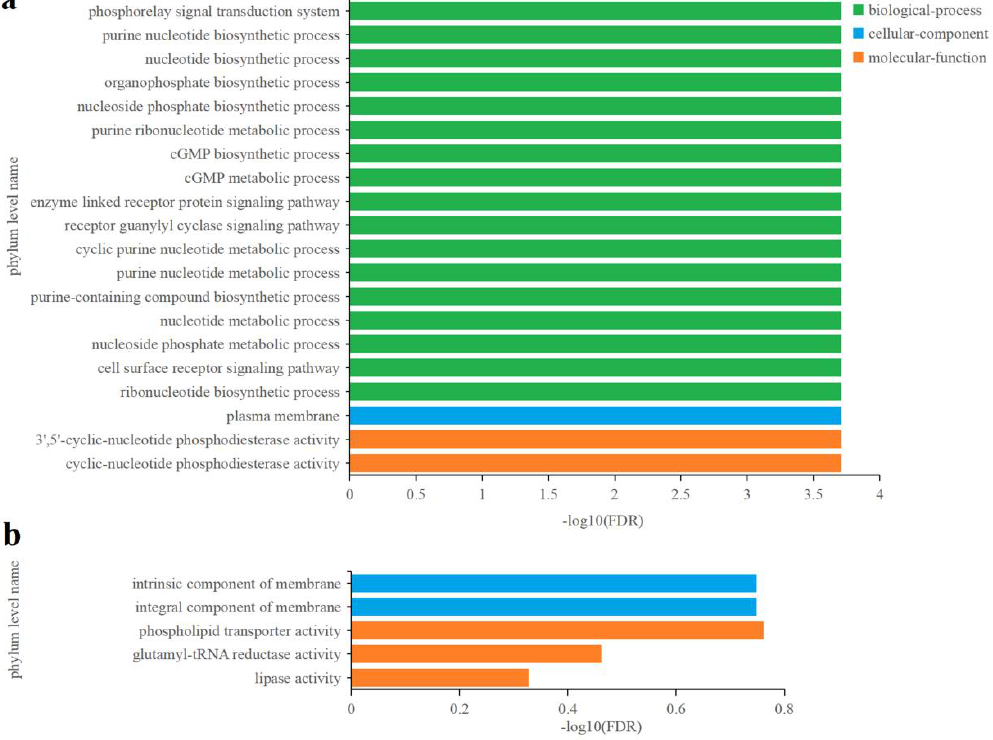
Figure 10. Gene Ontology (GO) enrichment analysis of differentially expressed genes (DEGs) in C. fusiformis under Cu 2+ treatment. ( a ) Upregulated genes in CFCu/CFC. ( b ) Downregulated genes in CFCu/CFC. Table 3. DEGs involved in heavy metal stress response in C. fusiformis under Cu 2+